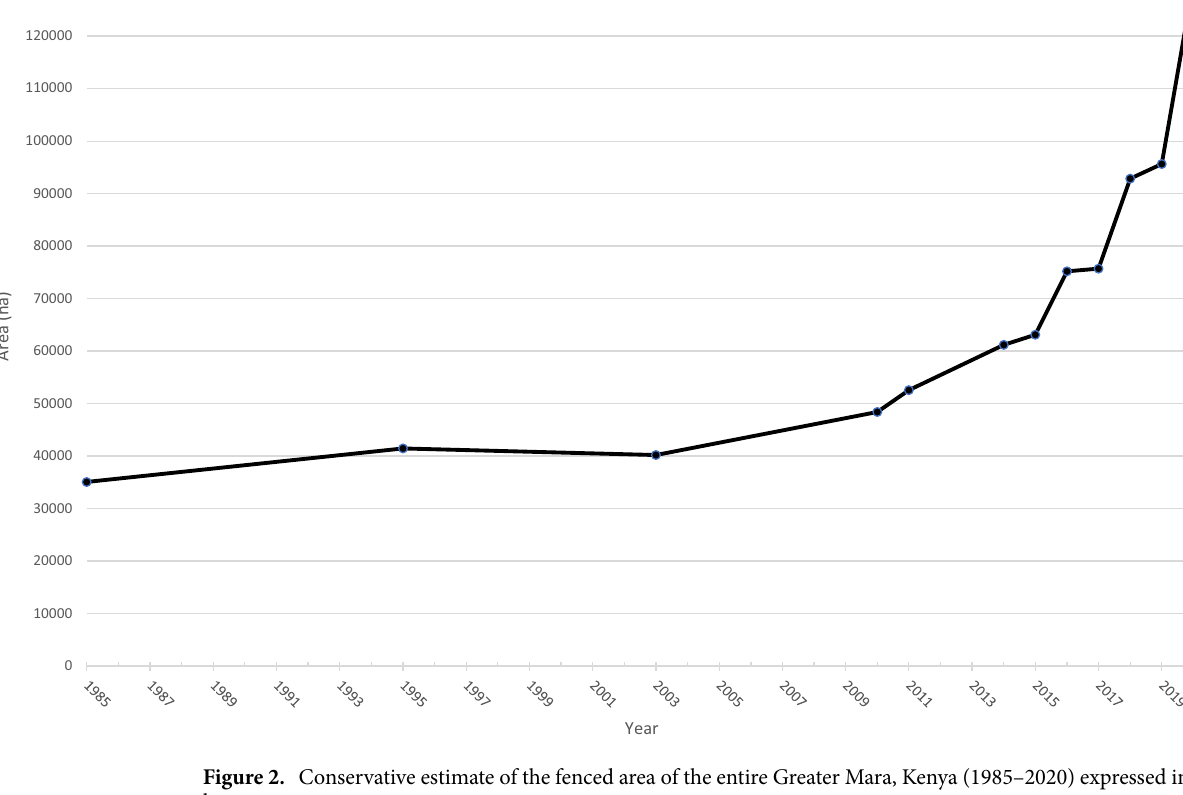
Figure 2. Conservative estimate of the fenced area of the entire Greater Mara, Kenya (1985–2020) expressed in